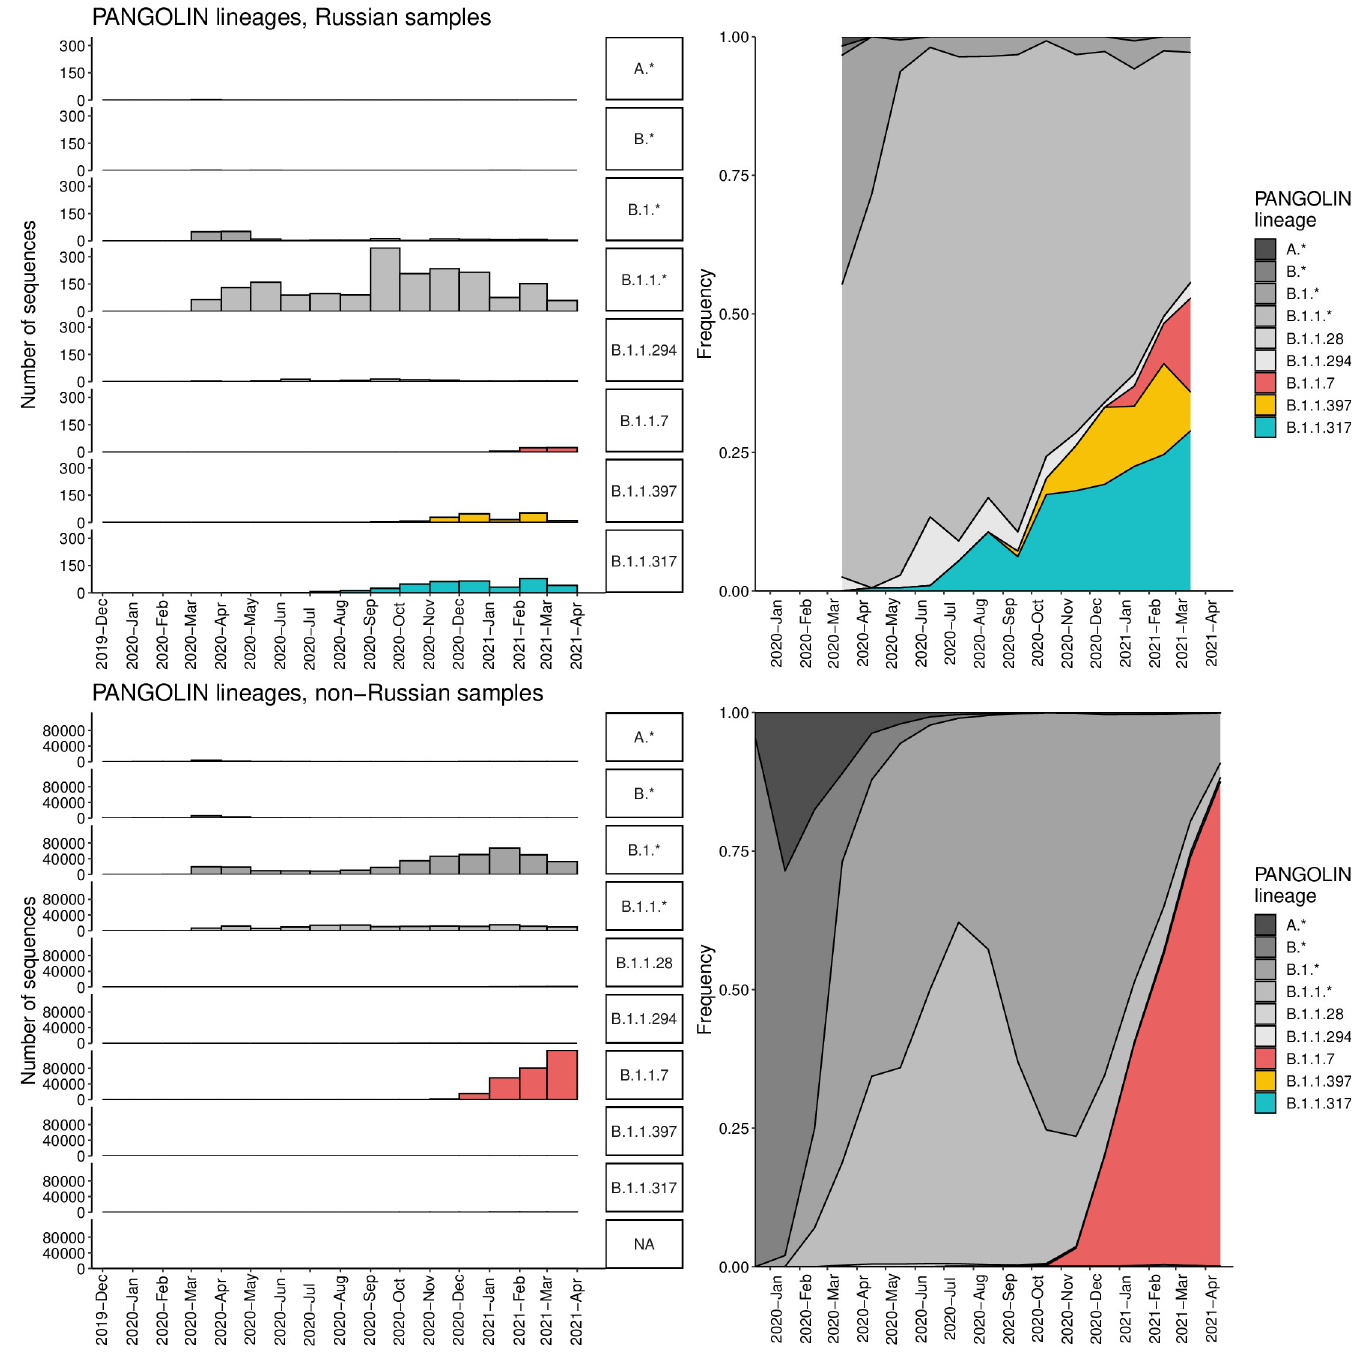
Fig 1. Dynamics of Pango lineage frequencies in Russia (top row) and among the non-Russian samples in GISAID (bottom row). Asterisks in Pango lineage designations correspond to pooled sets of lineages of that hierarchy level, except those listed in other categories; e.g., B.1.1. � includes B.1.1 and B.1.1.6 but not B.1.1.7 or B.1.1.317. Samples are split into one month